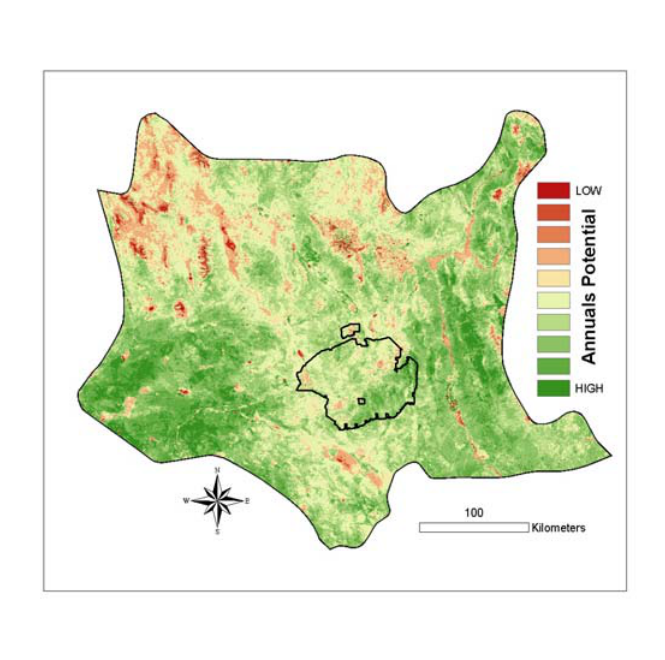
Figure 8. Proxy for annual growth potential in the Mojave Desert based on analysis of MODIS-EVI data. In this image, which is a re-scaled version of the 2005 model shown in Figure 7 (see text), areas with greener values correspond to areas predicted to have high annual growth